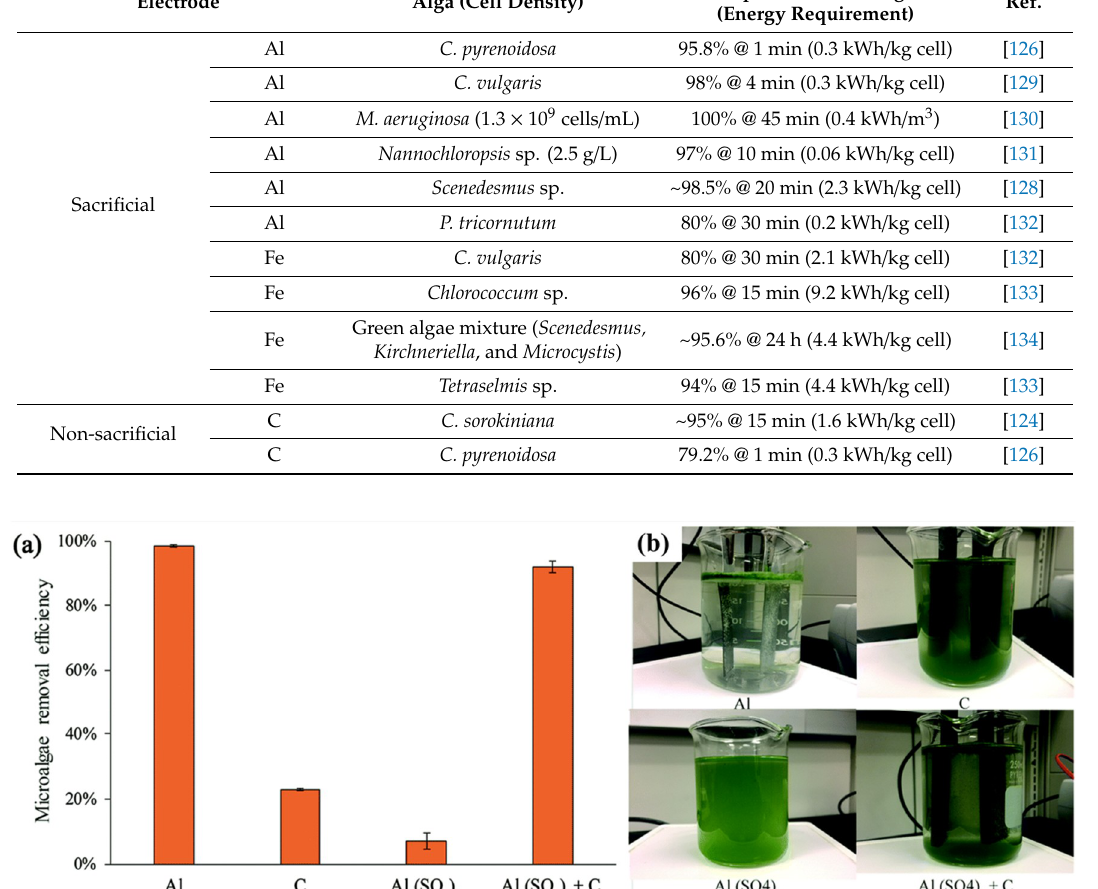
Table 5. Comparison of sacrificial and non-sacrificial electrodes for algae harvesting.